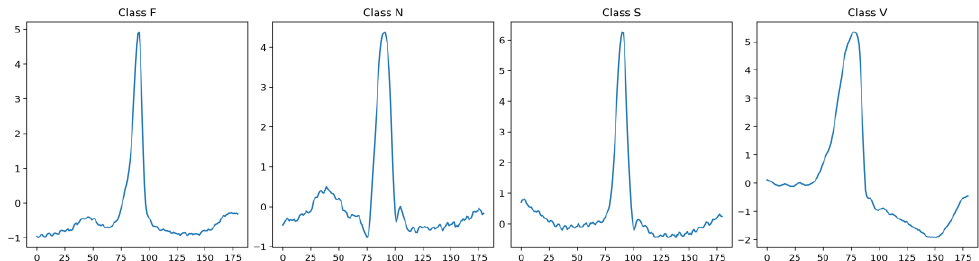
Figure 1. Example ECG patterns for different heartbeat types.